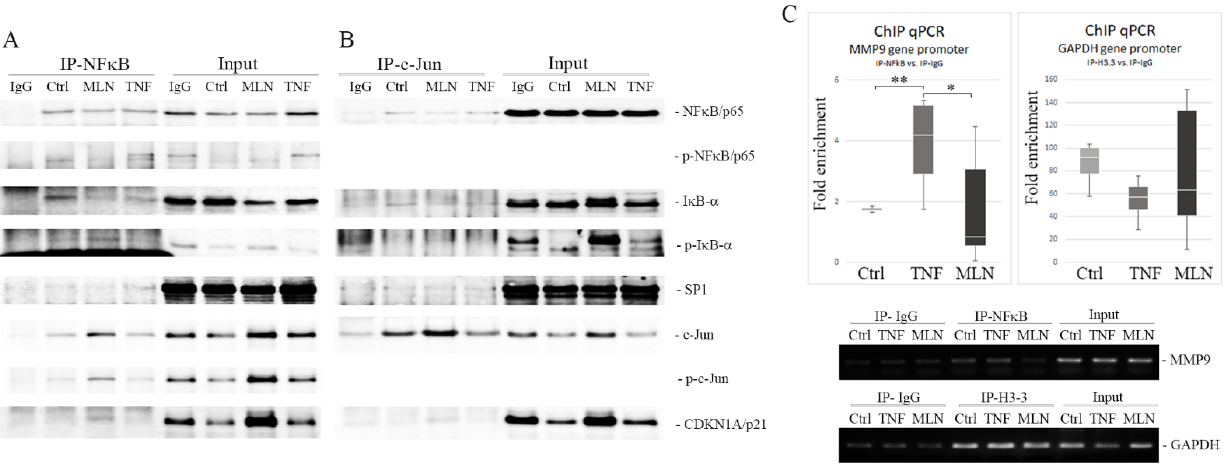
Figure 4. Western blot analysis of the nuclear factor kappa B (NF κ B) complex and the chromatin immunoprecipitation (ChIP)-quantitative polymerase chain reaction (qPCR) assay of the matrix metalloproteinase 9 ( MMP9 ) gene promoter in KYSE150 cells. Nuclear protein-enriched extracts from esophageal squamous cell carcinoma (ESCC) cells were used for co-immunoprecipitation (co-IP) with a mouse anti-NF κ B/p65 antibody ( A ) or with a rabbit anti-c-Jun antibody ( B ) and probed for inhibitor of nuclear factor kappa B-alpha (I κ B- α )/phospho-I κ B- α , SP1 and cyclin dependent kinase inhibitor 1A (CDKN1A/p21) as well as phosphorylated and unphosphorylated forms of NF κ B/p65 and c-Jun. Immunoglobulin G (IgG) mixture (1:1:1) of each protein extract and normal mouse IgG or normal rabbit IgG, respectively, used as negative controls; Ctrl—protein extract from untreated cells; MLN4924 and tumor necrosis factor-alpha (TNF- α )—extracts from cells treated with MLN4924 (1 µM) for 24 h and with TNF- α (30 ng/mL) for 1 h, respectively. ( C ) ChIP-qPCR assay on the MMP9 gene promoter in KYSE150 cells. Sheared chromatin was immunoprecipitated with antibodies against NF κ B/p65 and with an anti-acetyl histone H3.3 antibody, used as a positive control. Normal rabbit IgG served as a negative antibody control. Box plots showing qPCR data normalized with the fold enrichment method. Values shown are means ± SEM: whiskers: min–max; * p < 0.001, ** p < 0.01 vs. controls. Agarose gels showing DNA fragments amplified with MMP9 and glyceraldehyde 3-phosphate dehydrogenase (GAPDH)